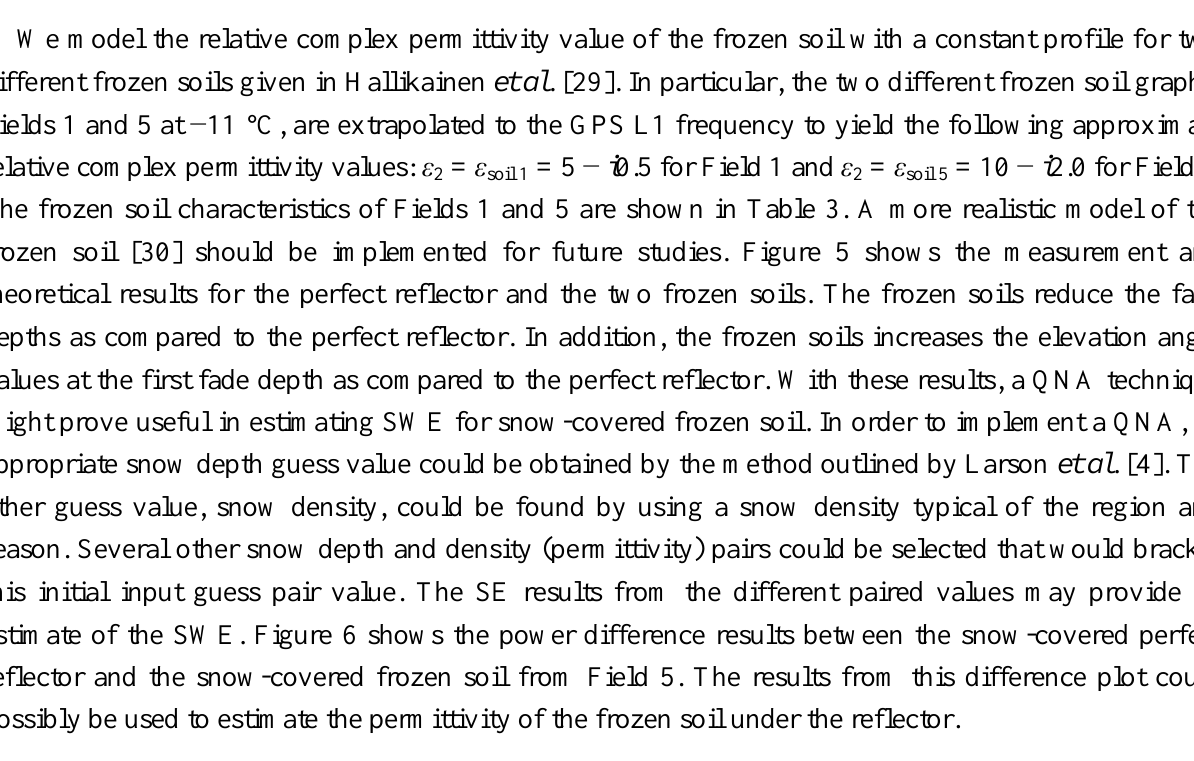
Table 3. Frozen soil characteristics of Fields 1 and 5 as given in